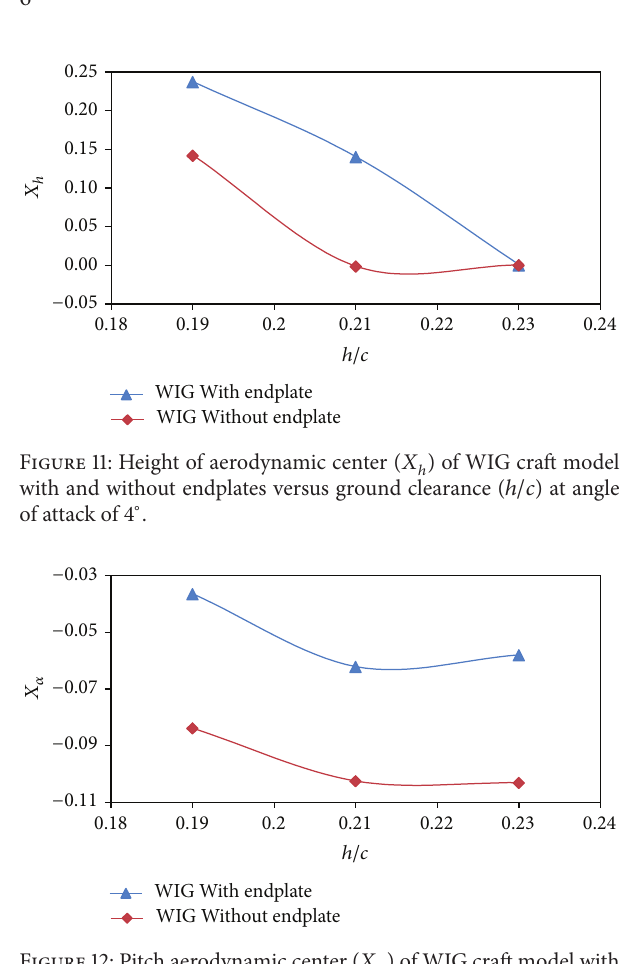
Figure 12: Pitch aerodynamic center ( 𝑋 𝛼 ) of WIG craft model with and without endplates versus ground clearance ( ℎ/𝑐 ) at angle of attack of 4 ∘ .